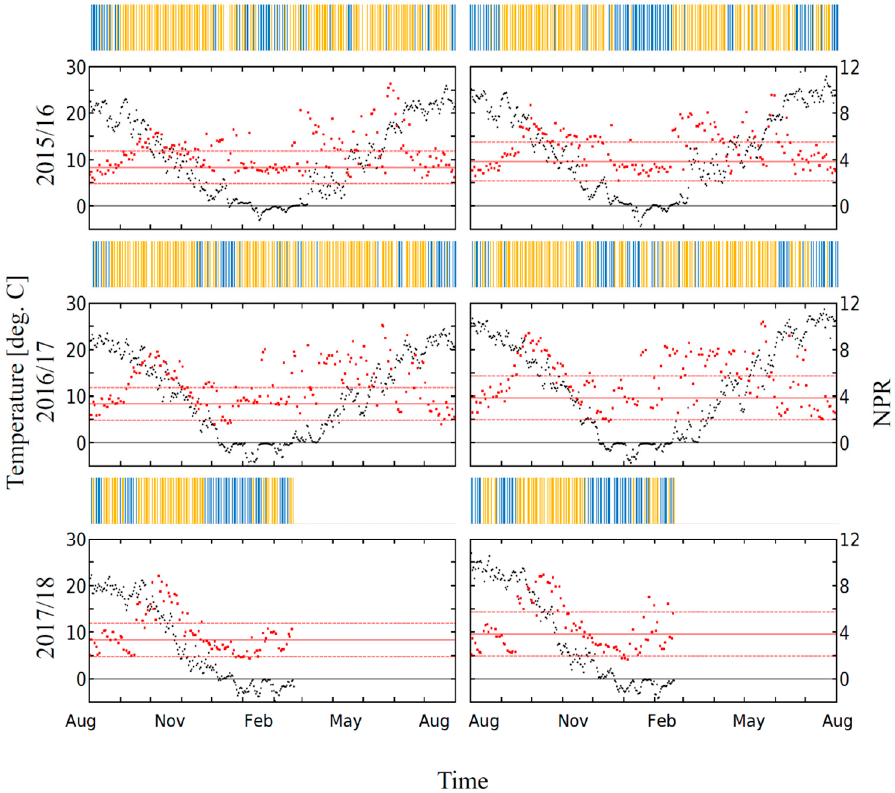
Figure 4. Same as Figure 3 but for Iowa (site 1607, grid 62891).